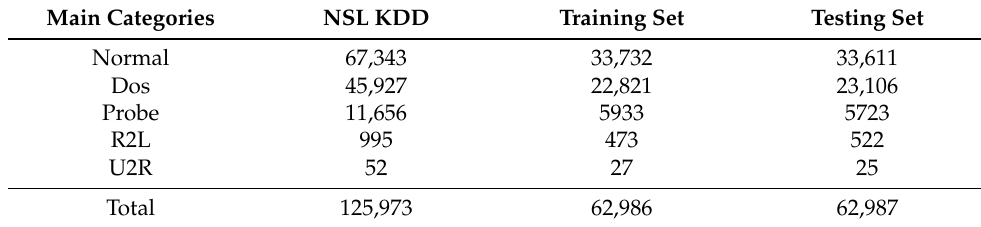
Table 4. The distribution of the